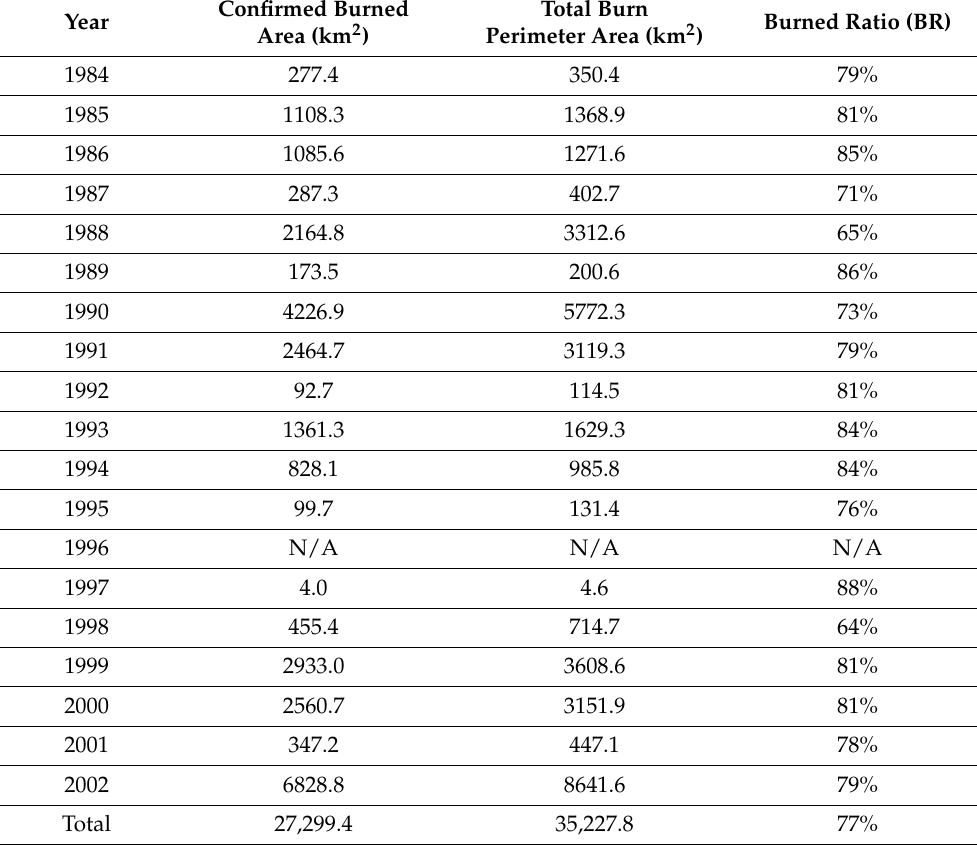
Table 2. The BR values calculated for each year between 1984 and 2002 as well as the entire 19-year period. The year 2006 is left blank due to a lack of coverage of 2006 wildfires by the MTBS